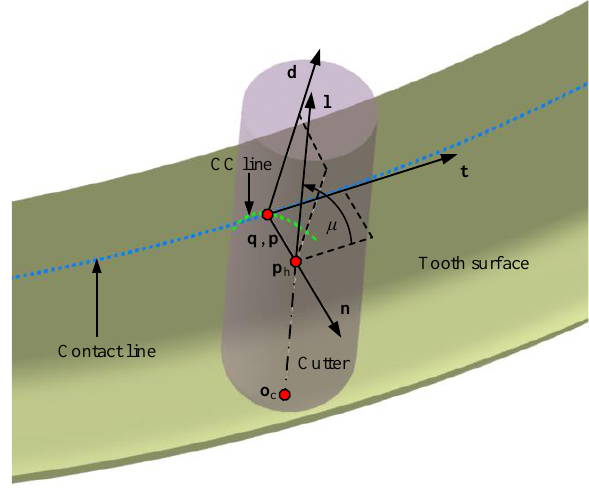
Figure 3. Tool path planning